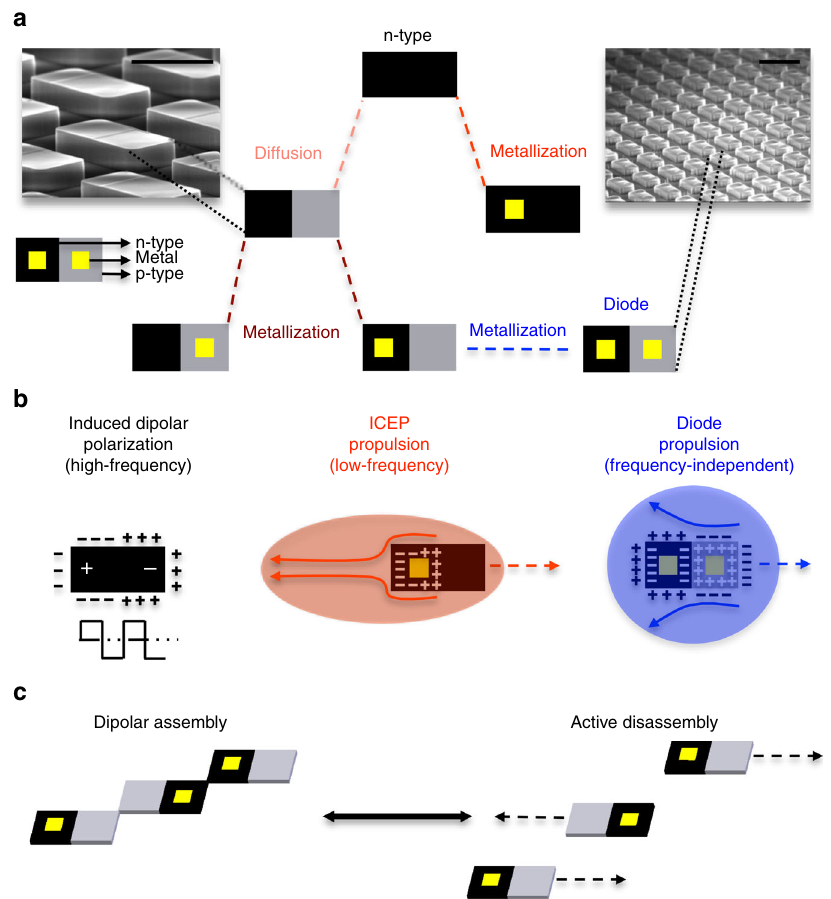
Fig. 1 Semiconductor microparticle types and their controlled locomotion and interaction in AC electric fi elds. a Scanning electron microscope (SEM) images of silicon (Si) microparticles (scale bar = 20 μ m) on bulk semiconductor substrates before separation (top corners) and schematics of different types of microparticles enabled by this integrated circuit fabrication approach (center). The black areas in the schematics represent Si with n-doped regions; the gray areas represent Si with p-doped regions; the yellow areas represent gold (Au) electrical contacts deposited on the microparticles. b Different types of semiconductor microparticles displaying three modes of programmed electrokinetic motion (from left to right): DEP, ICEP, and diode- based propulsion due to AC fi eld recti fi cation. In DEP, particles move due to induced dipoles formed from a non-uniform electric fi eld at high frequencies. In ICEP, particles move due to the higher polarizability of one region of the particle (e.g., the Au contact) compared with other regions of the particle. In diode- based propulsion, particles move due to the rectifying capability of the internal circuit to direct current in one direction. c Recon fi gurable assembly dynamics of active Si microparticles. At high frequencies ( ≥ 10 kHz), microparticles assemble by polarizing forces from DEP; at low frequencies (< 10